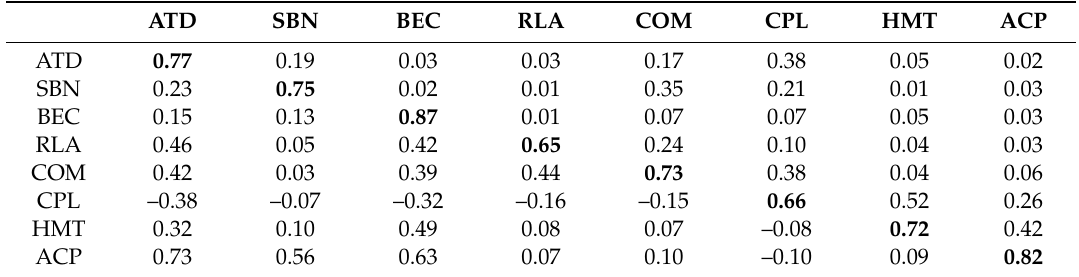
Table 4. AVE, correlations, and squared correlations of the constructs.